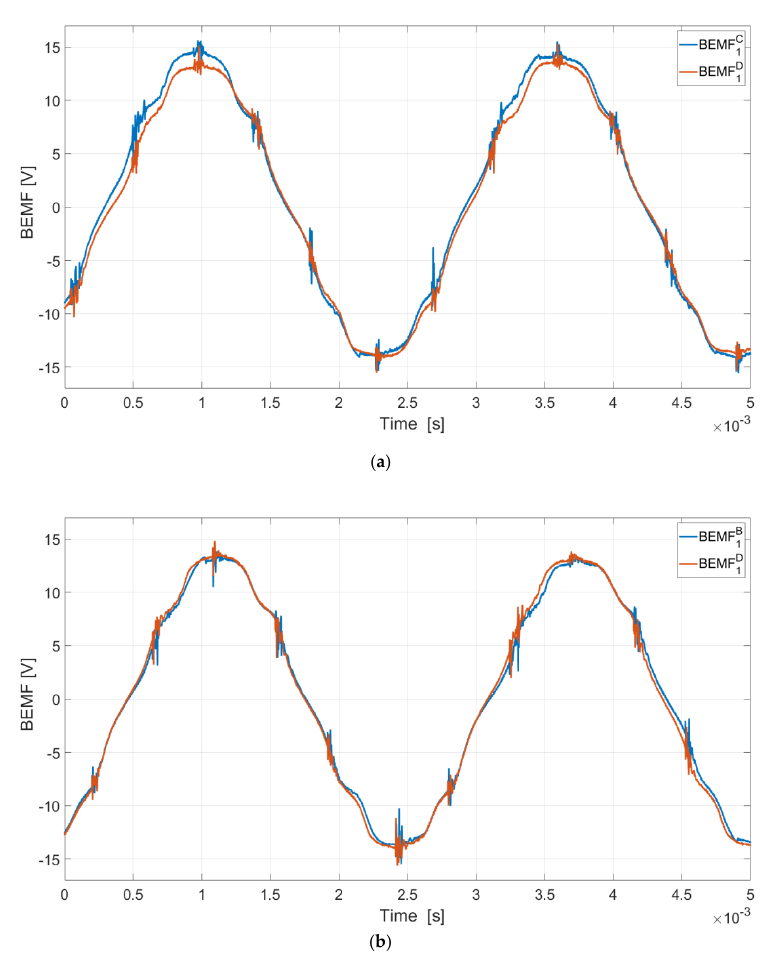
Figure 18. The induced voltages: DCO A and B mode ( a ), DCO A and C mode ( b ).